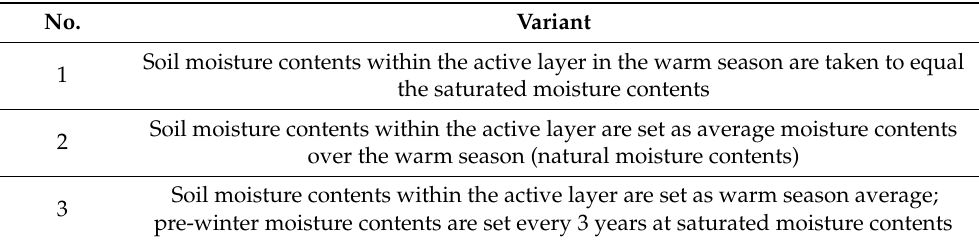
Table 6. Three different simulations with soil moisture variants in the modeling.